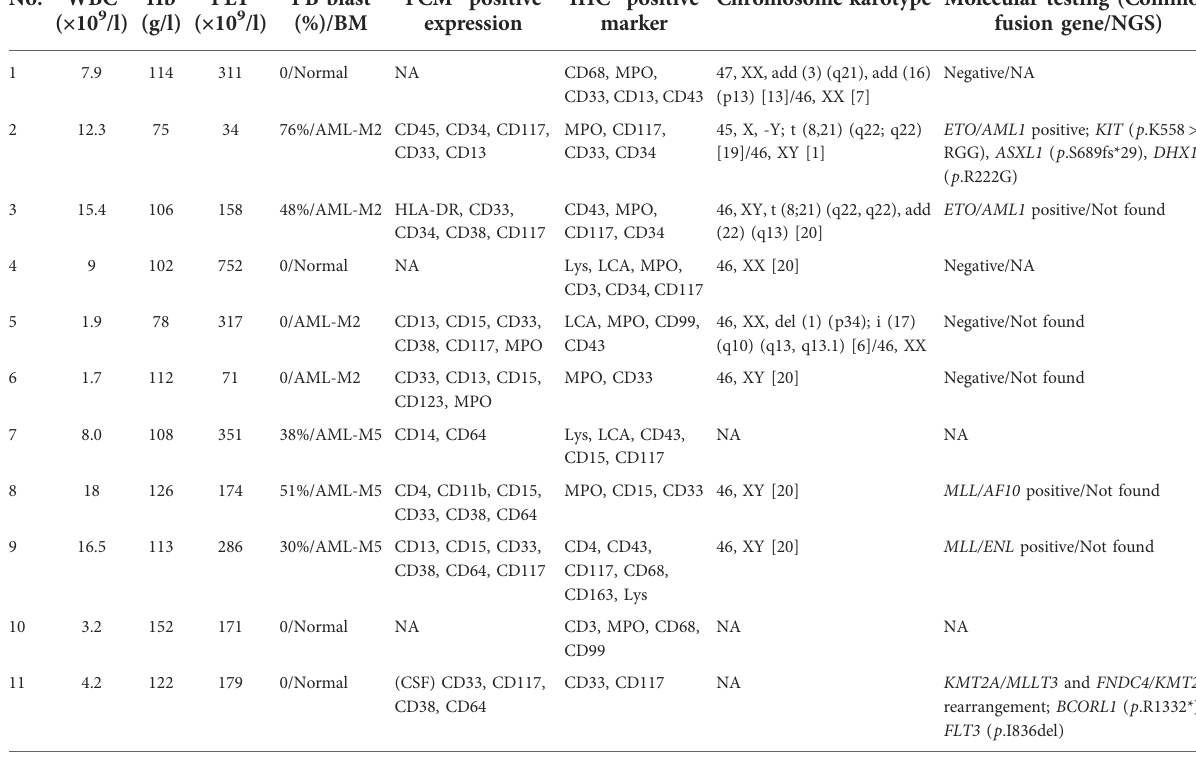
TABLE 2 Laboratorial, pathological and genetic characteristics of the patients with MS. Hb No. WBC (×10 9 /l)